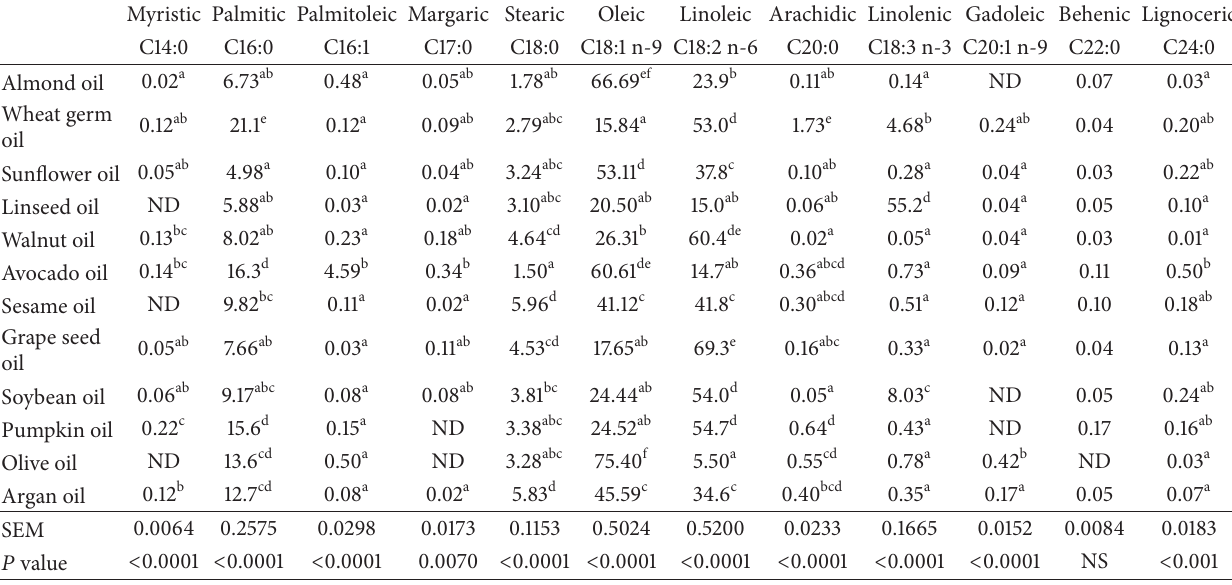
Table 3: Fatty acid composition (%) in edible vegetable oils ∗ .